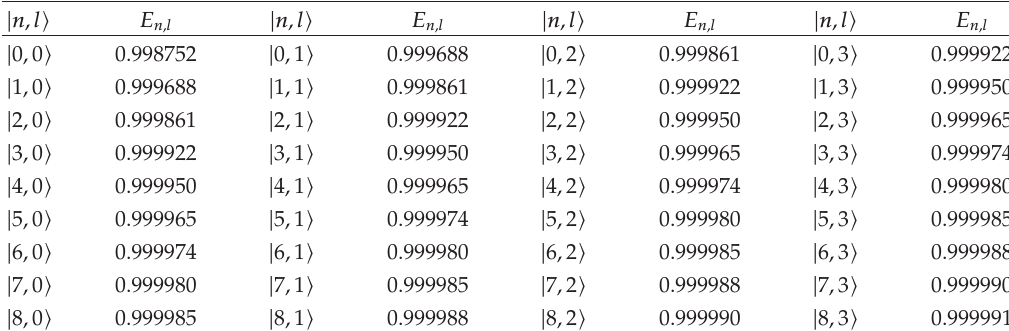
Figure 1: Wave functions for coulomb interaction versus r for (cid:3) m 0 (cid:9) 1, V 0 (cid:9) − 0 . 1, and l (cid:9) 0 (cid:5) . Table 1: Energy eigenvalues for coulomb interaction with (cid:3) m 0 (cid:9) 1, V 0 (cid:9) − 0 . 1 (cid:5)